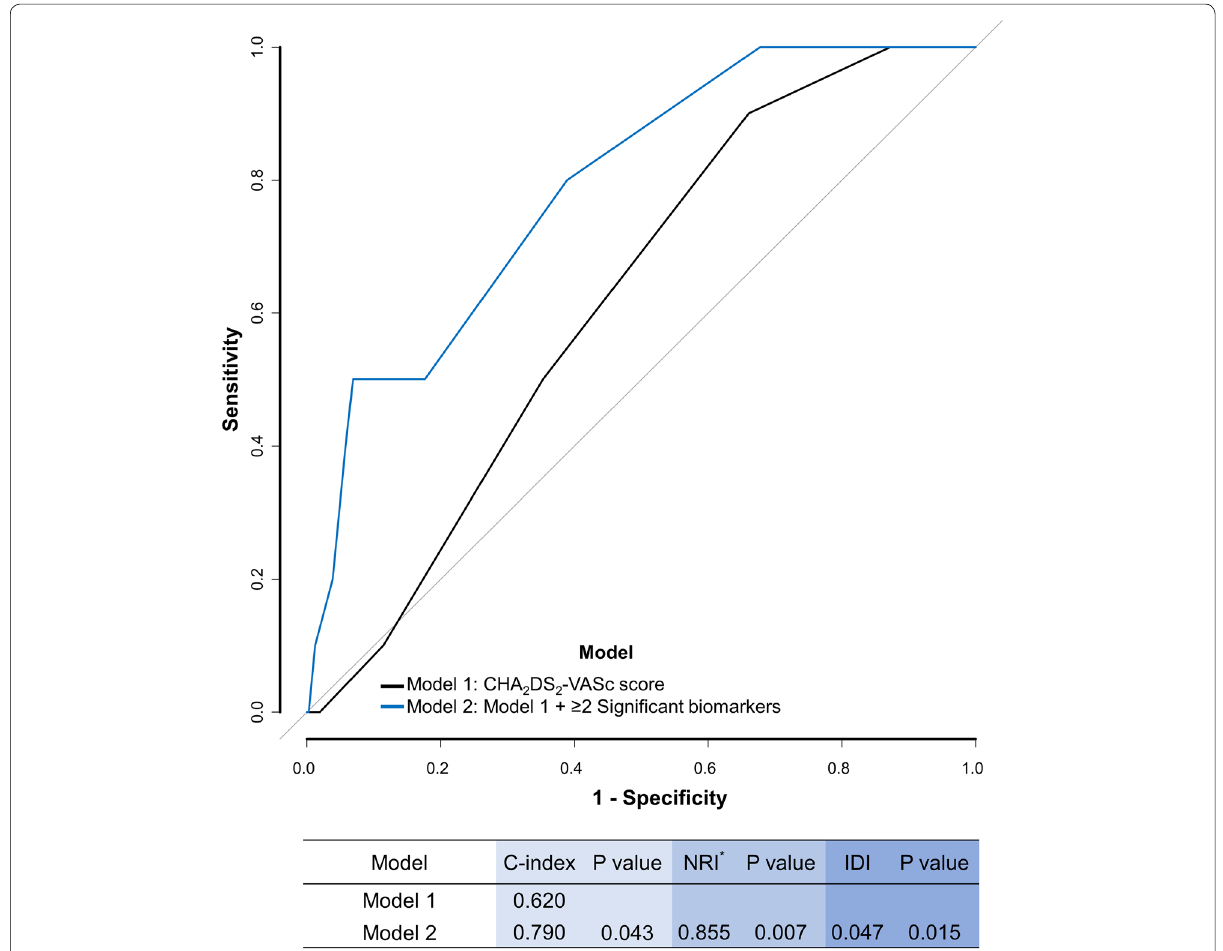
Fig. 3 Incremental prognostic value of 2 significant biomarkers over the CHA 2 DS 2 ‑VASc score. *category‑free NRI. The significant biomarkers were ≥ RDW 13.5%, creatinine 1.11 mg/dL, and PDW 13.2%. IDI integrated discrimination improvement; NRI net reclassification index; PDW platelet ≥ ≥ ≥ distribution width; RDW red cell distribution